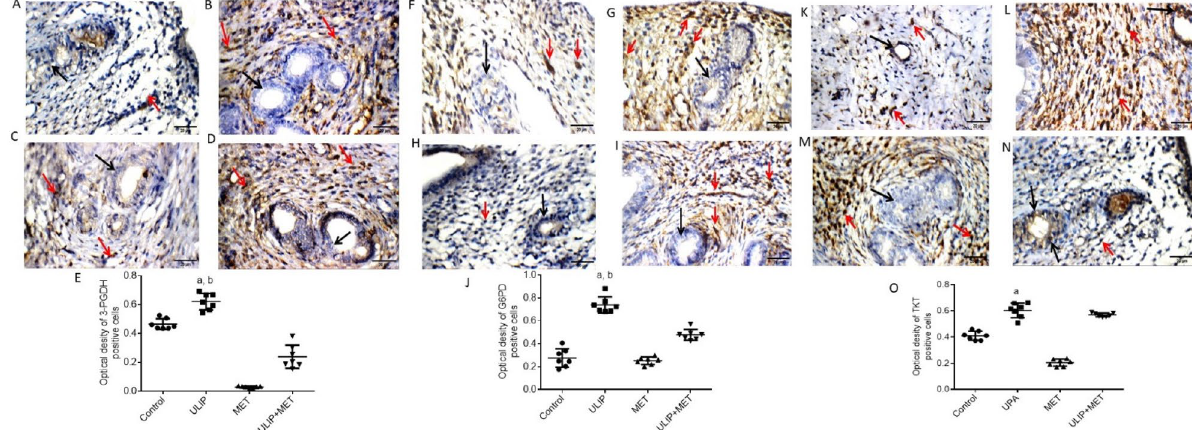
Figure 6. Effect of ulipristal and/or metformin on the expression of proteins involved in glucose metabolism in rats’ uteri. ( A – D ) photomicrographs of uteri shows expression of 3-PHGDH. ( A ) Uterine wall in the control group. ( B ) Uterine wall in ulipristal treated group. ( C ) Uterine wall in metformin treated group. ( D ) Uterine wall in the ulipristal and metformin treated group. × 400 magnification (scale bar = 20 μm). ( E ) Expression quantification of the optical density reactivity of positive cells of 3-PHGDH by the ImageJ analysis system. ( F – I ). Photomicrographs of uteri shows expression of G6PD. ( F ) Uterine wall in the control group. ( G ) Uterine wall in ulipristal treated group. ( H ) Uterine wall in metformin treated group. ( I ) Uterine wall in the ulipristal and metformin treated group. × 400 magnification (scale bar = 20 μm). ( J ) Expression quantification of the optical density reactivity of positive cells of G6PD by the ImageJ analysis system. ( K – N ) Photomicrographs of uteri shows expression of TKT. ( K ) Uterine wall in the control group. ( L ) Uterine wall in ulipristal treated